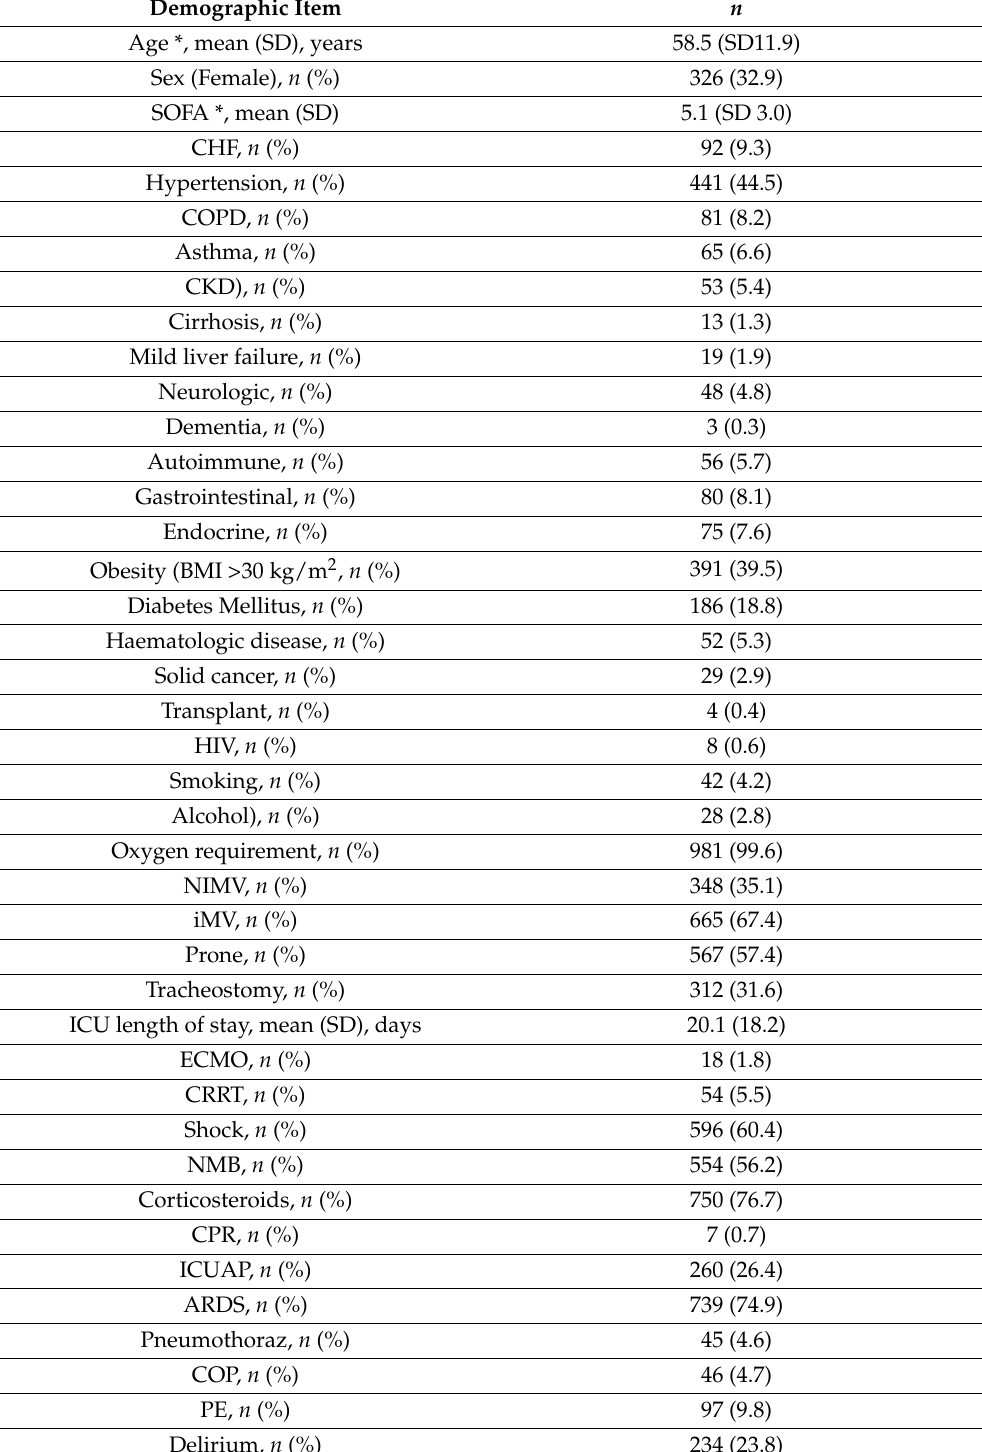
Table 1. Patient characteristics of the population enrolled in the study based on persistent post- COVID-19 symptoms at 3-month